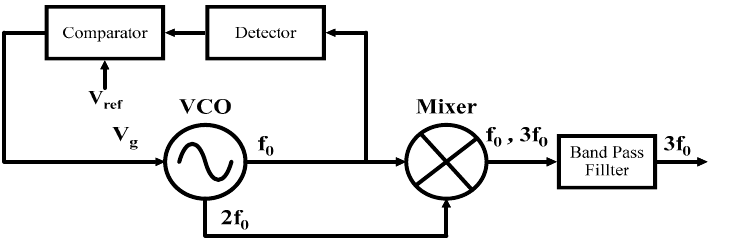
Figure 2. Block diagram of the proposed voltage controlled oscillator (VCO) with triple frequency.